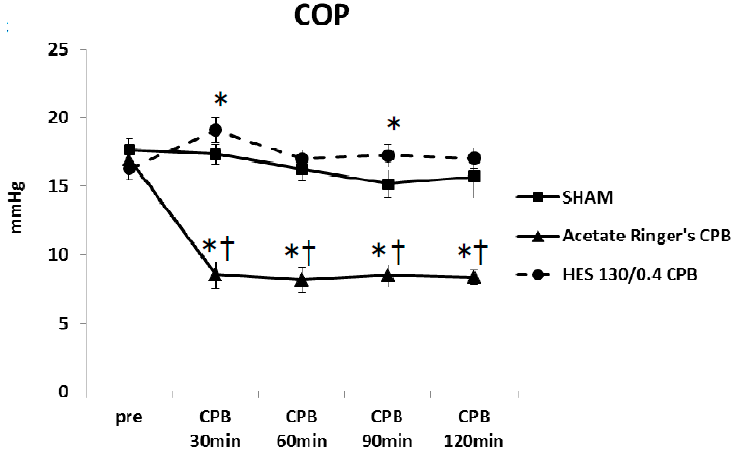
Figure 7. Colloid osmotic pressure (COP) during the experiment [35]. * p < 0.05 versus the SHAM group, † p < 0.05 versus the HES 130/0.4 CPB group at the same point in time.